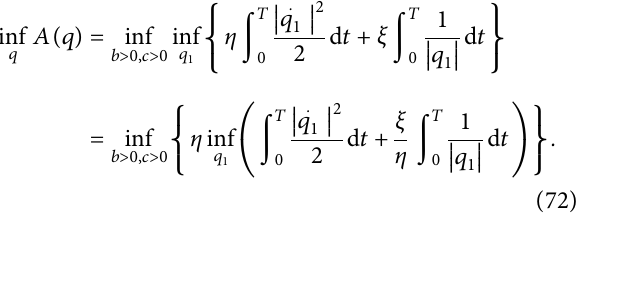
Figure 8: Region of existence of central configuration for the convex kite four-body configuration where m